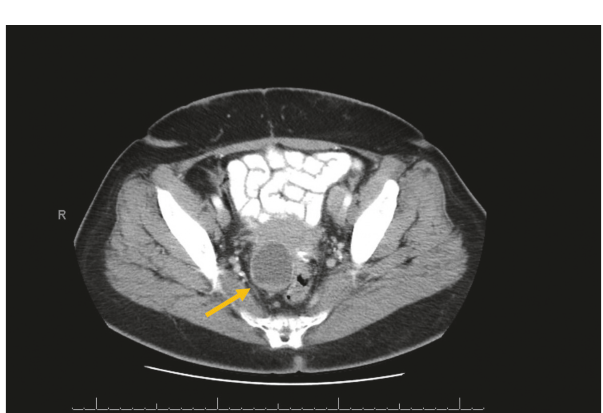
Figure 1: Sagittal image from CT scan following the intravenous administration of 100mL of Omnipaque 350 and 32 ounces oral Omnipaque 350 demonstrating simple paravaginal cystic structure with fluid density contents.